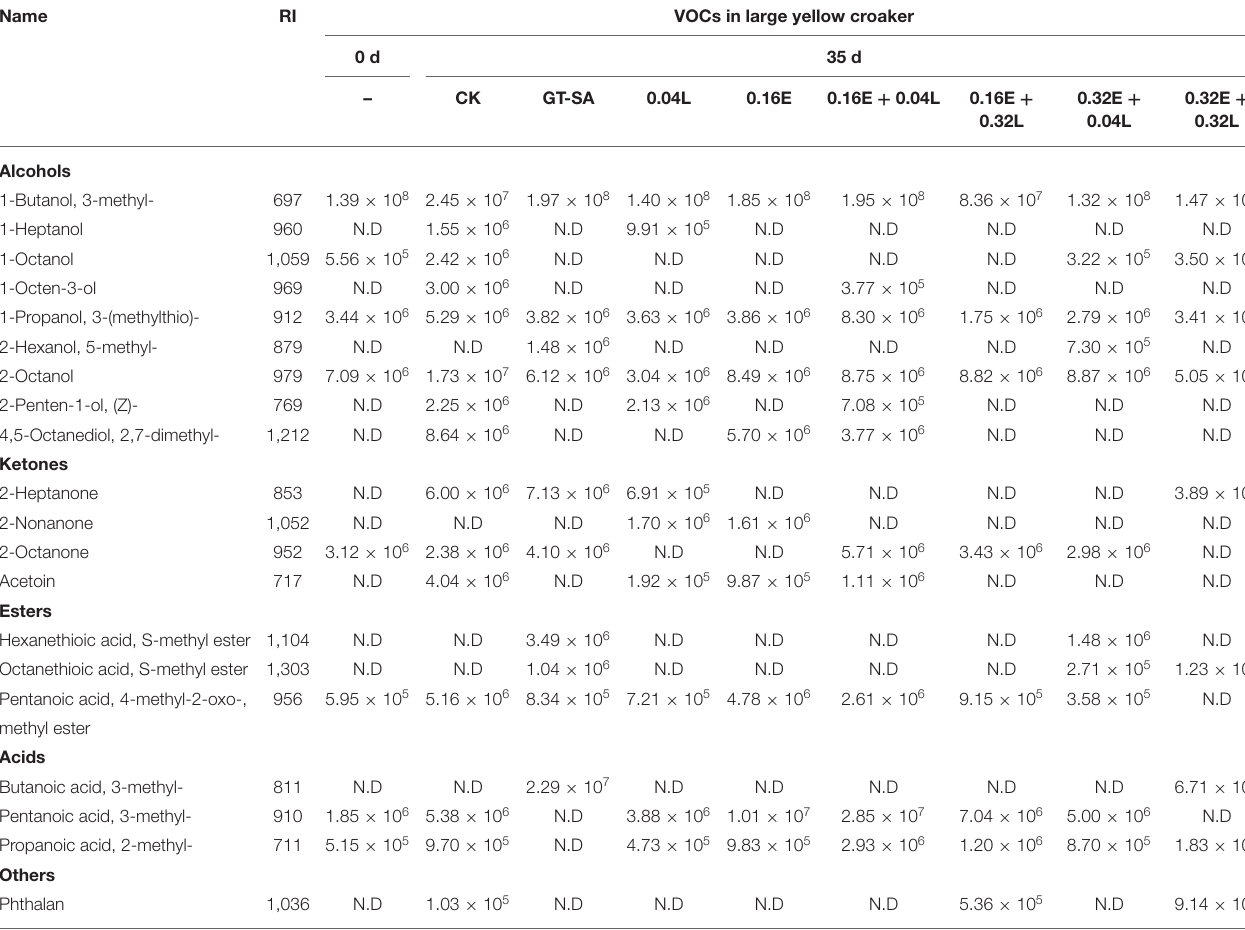
TABLE 5 | Retention index and area of main volatile compounds identified in large yellow croaker after 0 and 35 days of superchilling storage.